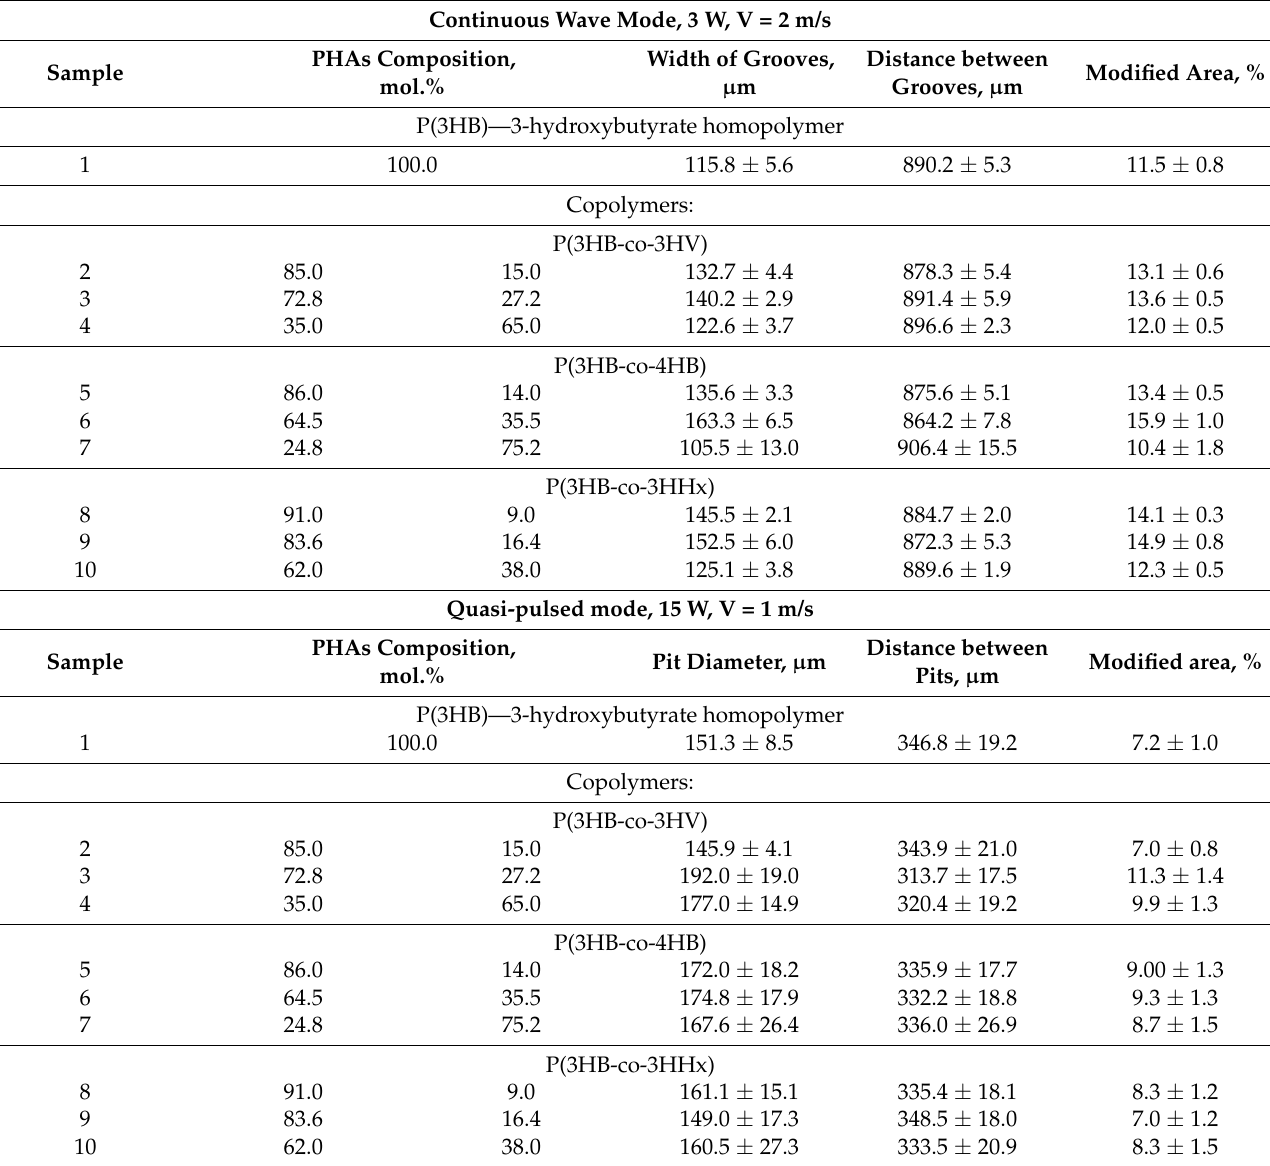
Table 2. Characterization of the surface structural elements of laser-treated films prepared from PHAs with different